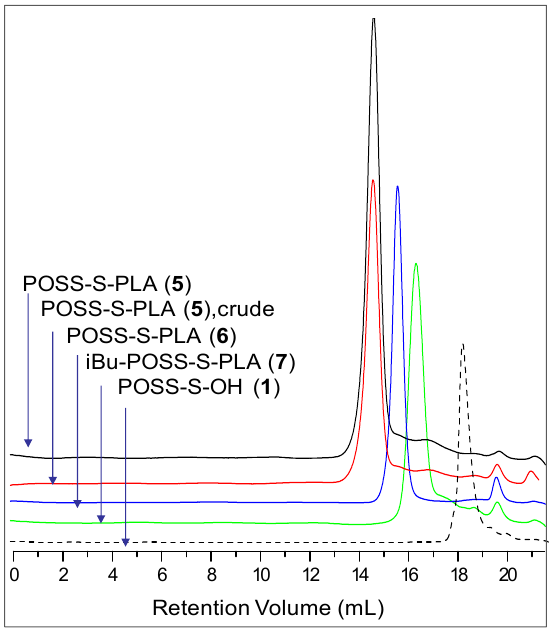
Figure 6. SEC traces of star-shaped (POSS-S-PLA)(5), M n (MALS) = 28,500, PDI = 1.15 before precipitation—red line, after precipitation in methanol—black line, (6) M n (MALS) = 9050, PDI = 1.07—blue line and (iBu-POSS-S-PLA)(7) M n (MALS) = 3600, PDI = 1.04—green line. Initiator (POSS-S-OH)(1)—black dashed